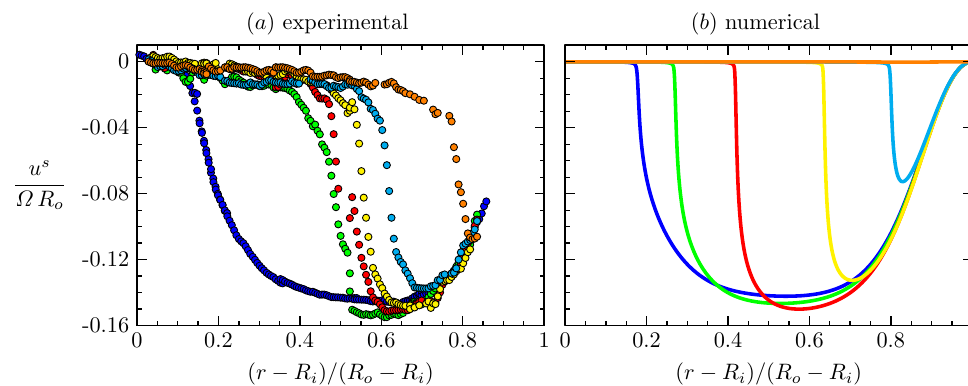
Figure 9. Radial profiles of the radial velocity at the interface, u s ( r ) over the annular gap r ( R i , R o ) measured in a deep-channel surface viscometer (Figure 8), ( a ) experimentally measured via boundary-fitted PIV at steady state for initial vitamin K 1 monolayer surface concentrations: c 0 = 0 (blue), c 0 = 0.1mg/m 2 (green), c 0 = 0.2 mg/m 2 (red), c 0 = 0.4 mg/m 2 (yellow), c 0 = 0.6 mg/m 2 (cyan), c 0 = 0.8 mg/m 2 (orange), at Reynolds number Re = Ω R 2 o / ν = 8500, together with ( b ) the corresponding numerical profiles at nominally the same c 0 and Re . Note that the blue numerical profile corresponds to c 0 = 0.05 mg/m 2 , suggesting that there are some residual surfactants in the experiments without a monolayer being added. (Reproduced with permission from [17], published by Cambridge University Press